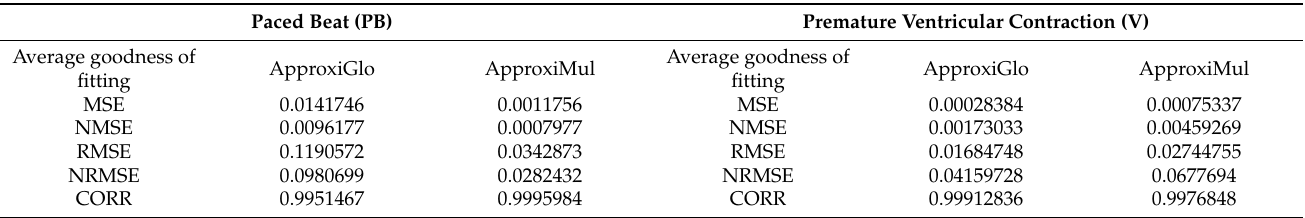
Table 3. Comparison between ApproxiGlo and ApproxiMul for paced beat and premature ventricular contraction